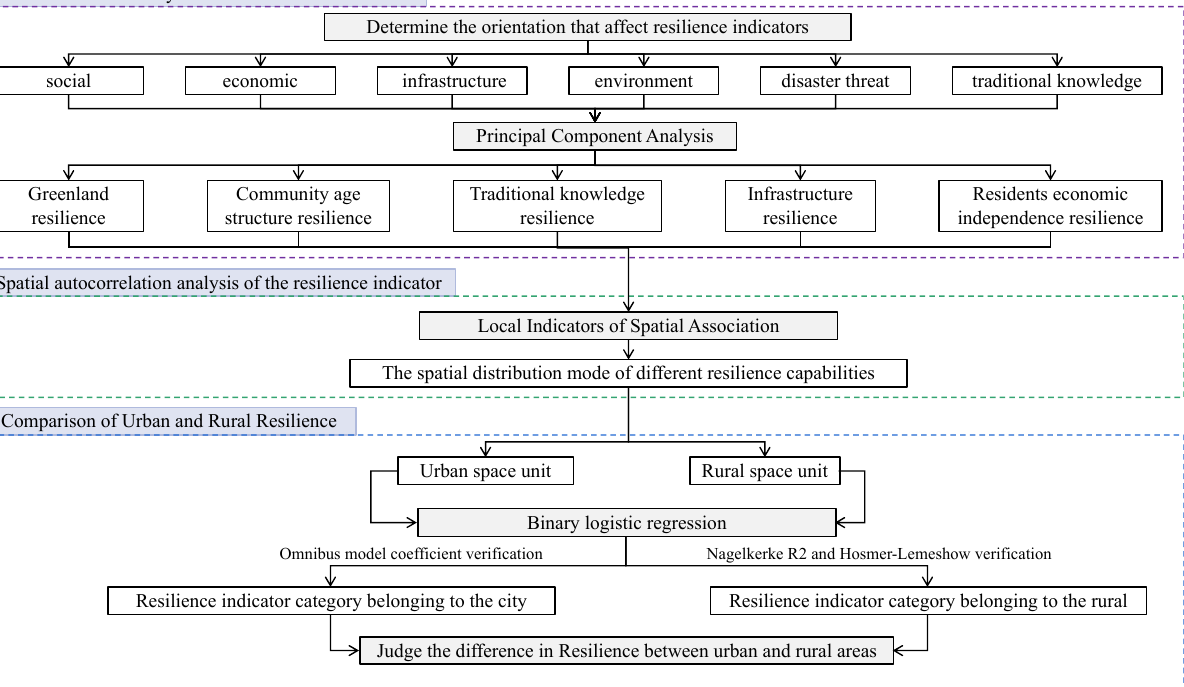
Figure 1. Research framework for comparing urban and rural resilience.